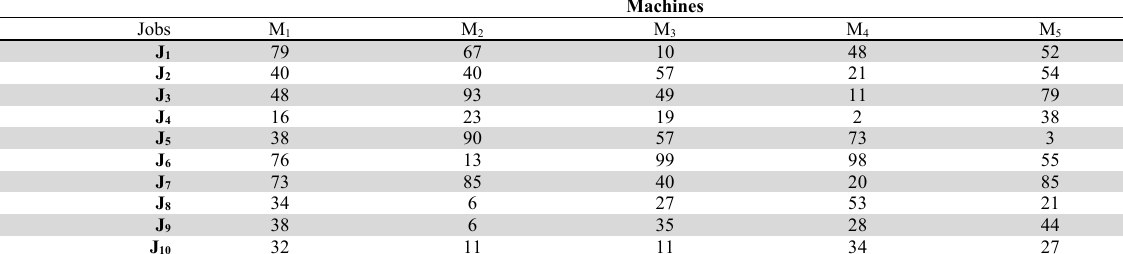
Data of processing time of 10 jobs on 5